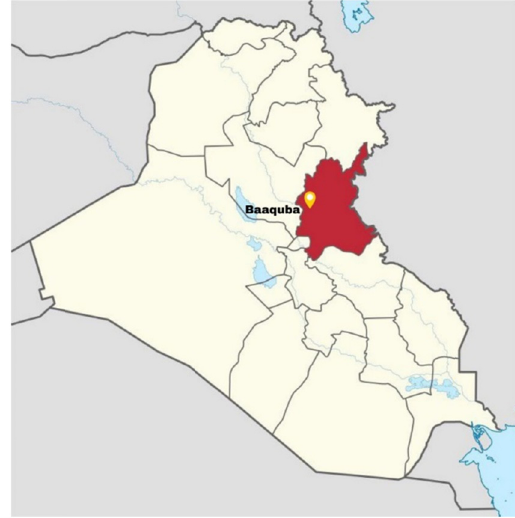
Figure 1: Location of the study area.